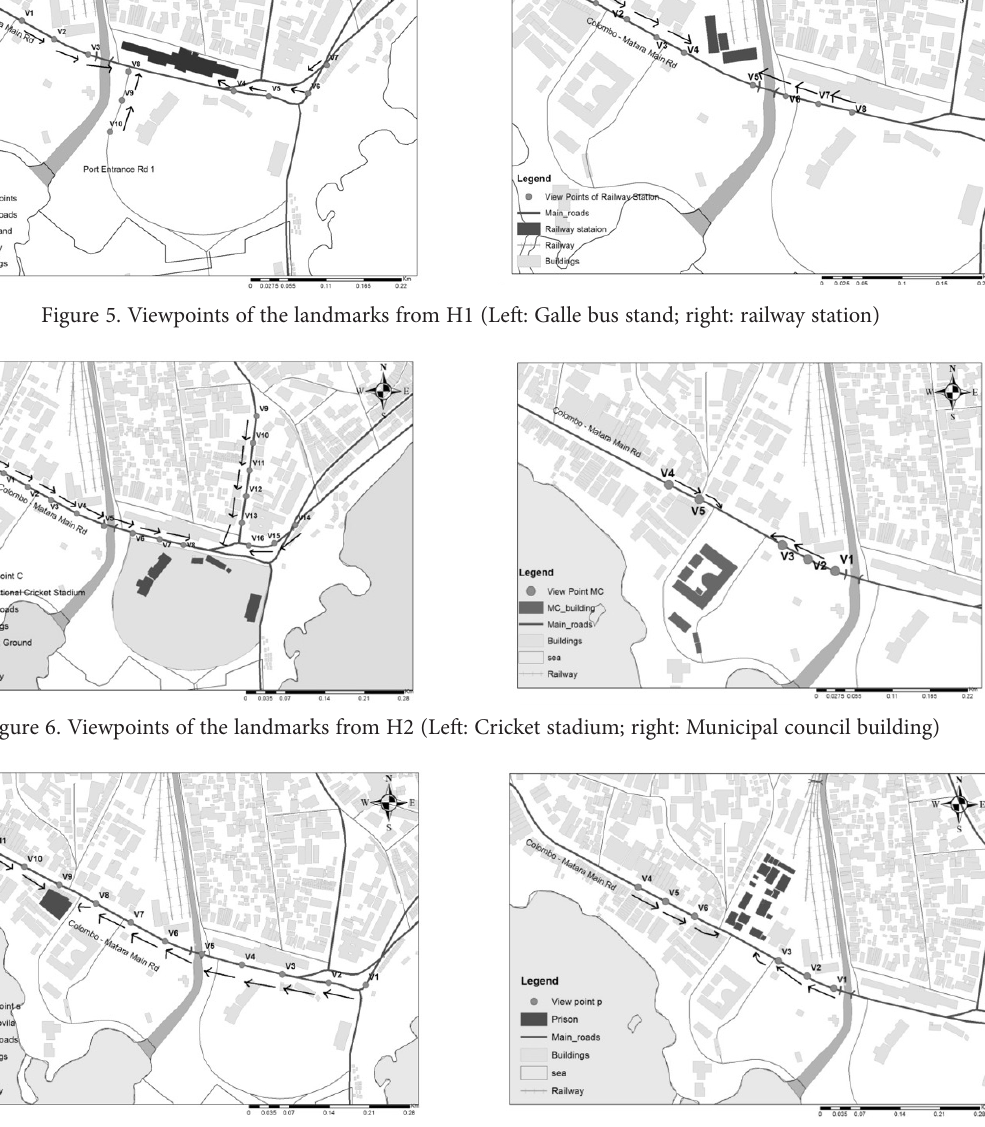
Figure 7. Viewpoints of the landmarks from H3 (Left: Siva kovil; right: Prison